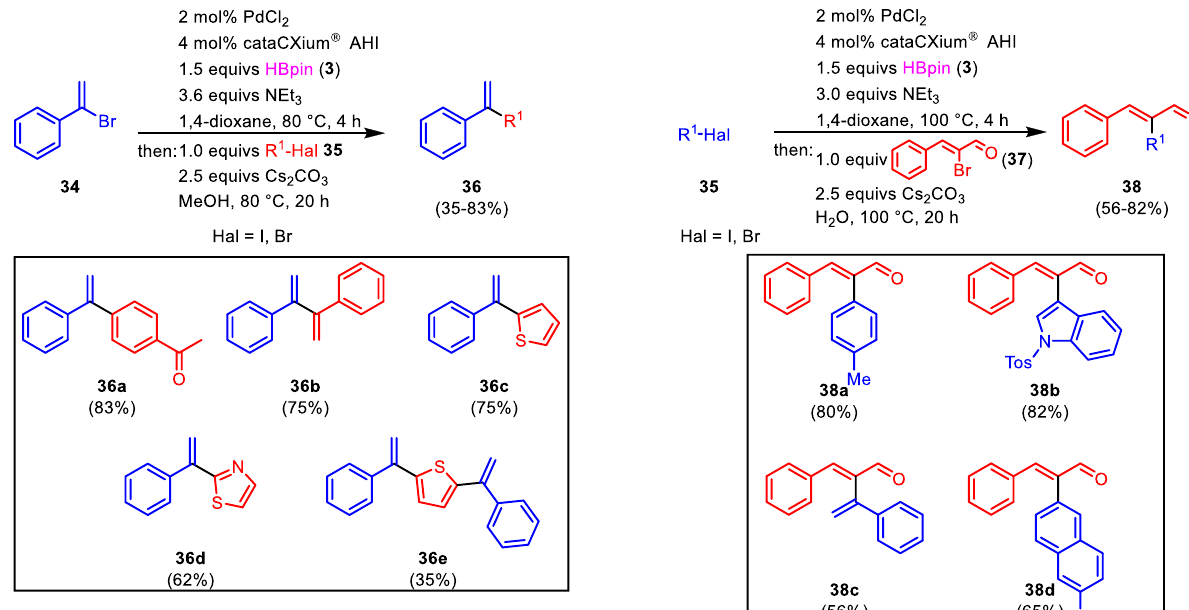
Figure 24. One- pot MBSC synthesis of α -substituted styrenes 36 and α -substituted cinnamalde- Figure 24. One-pot MBSC synthesis of α -substituted styrenes 36 and α -substituted cinnamaldehydes hydes 38 by Tasch et al. [54]. 38 by Tasch et al.